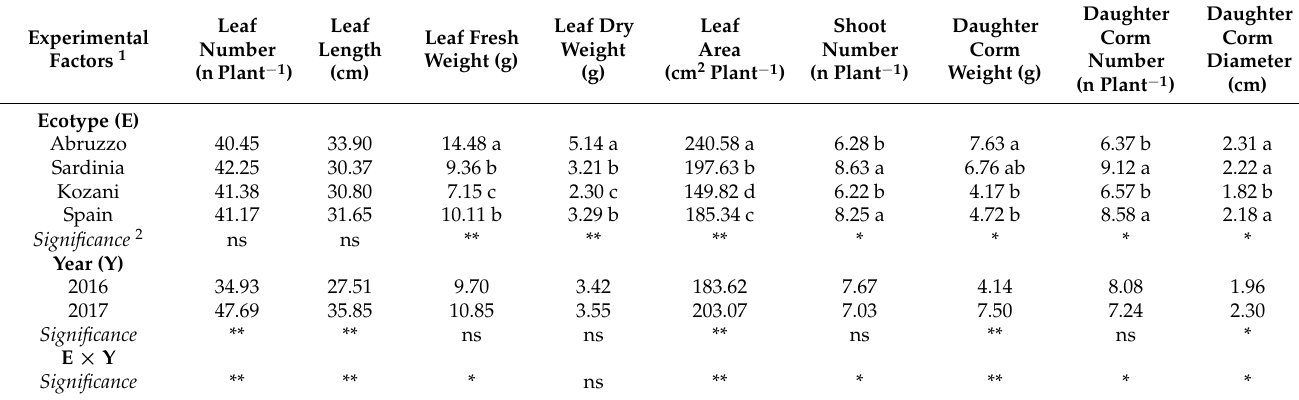
Table 5. Leaf development and daughter corm multiplication traits related to ecotype (E), year (Y) and their interaction. Experimental Factors